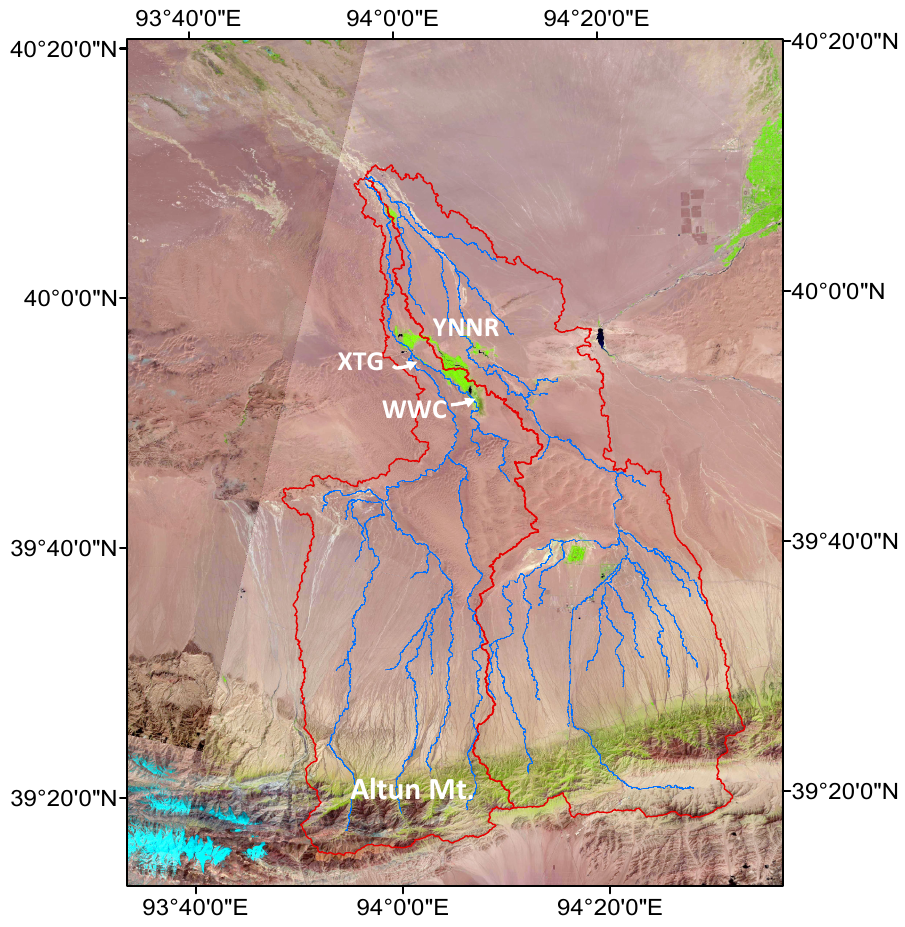
Figure 3. The hydrologic regime of the YNNR. The blue lines are channel networks, and the red lines are watershed